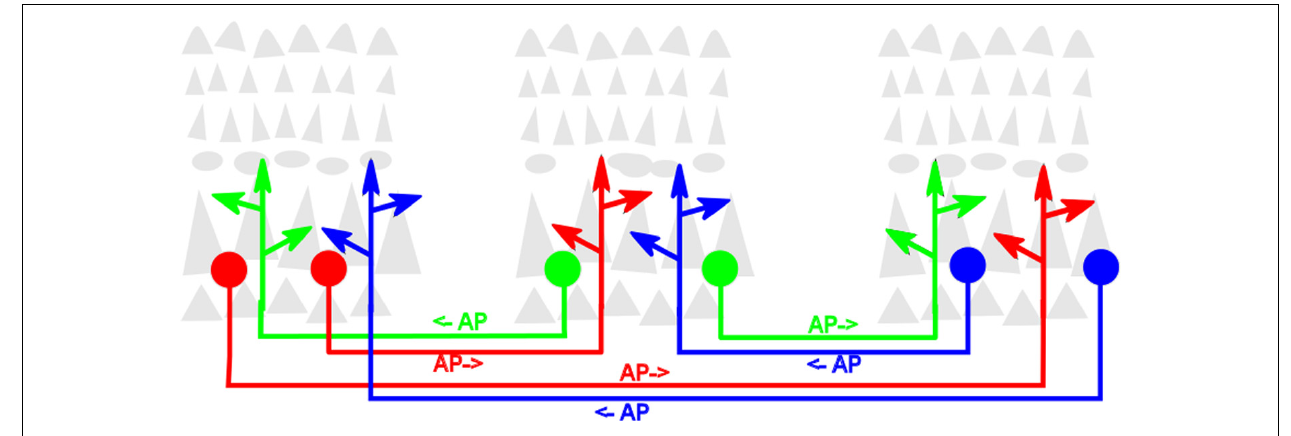
FIGURE 1 | Schematic diagram of reentrant white-matter fiber bundles linking distant cortical areas. Gray triangles represent pyramidal neurons that comprise the bulk of neocortical gray matter. For clarity, the dense packing of axonal and dendritic arbors that link neurons within the cortical